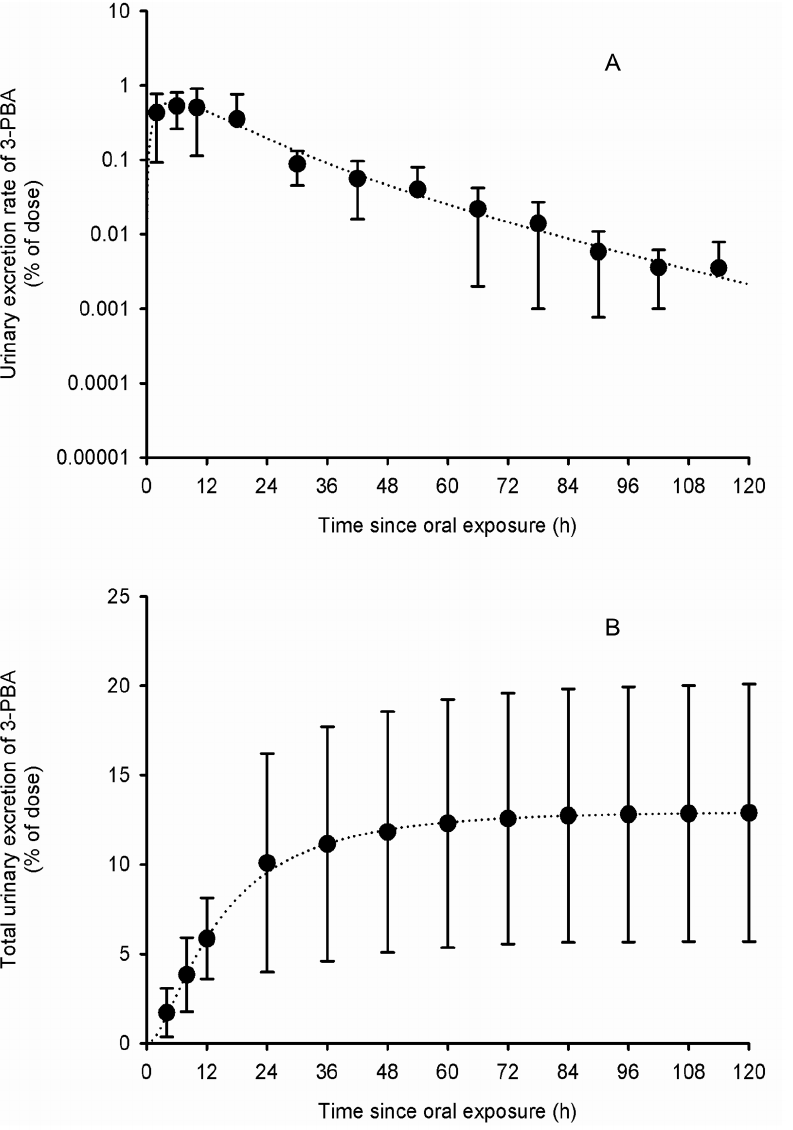
Figure 4. Comparison of model simulations with experimental data for 3-PBA (volunteers orally exposed). Comparison of model simulations (lines) with experimental data of Woollen et al. (1992) (symbols) on the average time courses of 3-PBA excretion rate (A) and cumulative excretion (B) (% of administered dose) in volunteers orally exposed to 3.3 mg of cypermethrin. Symbols represent average experimental values and vertical bars the experimental standard deviation